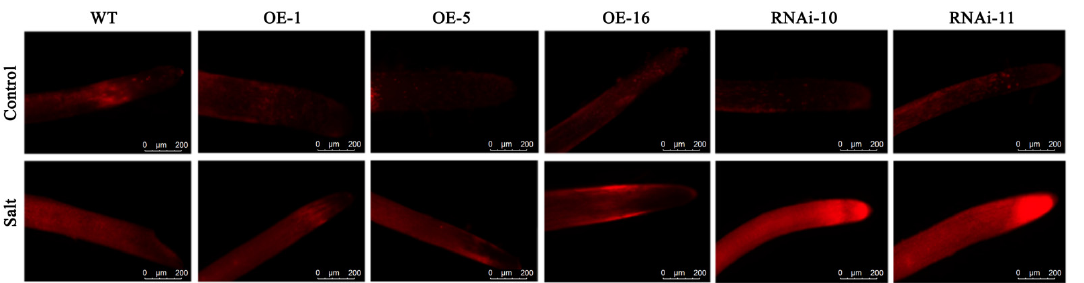
Figure 4. Effects of NaCl stress on the root cell membrane integrity. The plasma membrane integrity in root cells was checked by using propidium iodide (PI) staining. The PI staining experiment re ‐ vealed the distinctive root cell membrane integrity of overexpressed transgenic lines upon salt stress. The PI staining image of the root elongation zone (three independent experiments) for each treatment. Bars = 200 μ